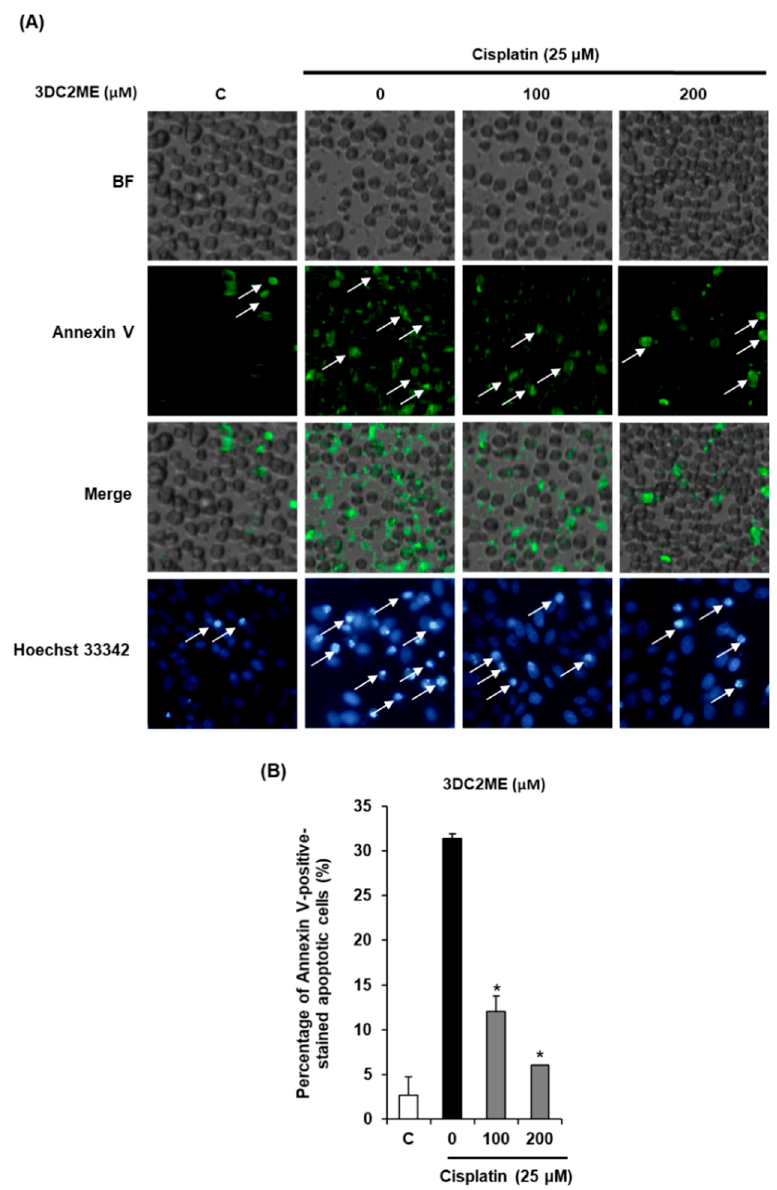
Figure 2. Effects of 3DC2ME on apoptosis in LLC-PK1 cells exposed to 25 μ M cisplatin for 24 h (image-based cytometric assay and Hoechst 33342 staining). ( A ) Representative images for apoptosis, ( B ) percentage annexin V-positive-stained apoptotic cells. Control cells were treated with the vehicle only (mean ± SD, * p < 0.05 compared to the control).